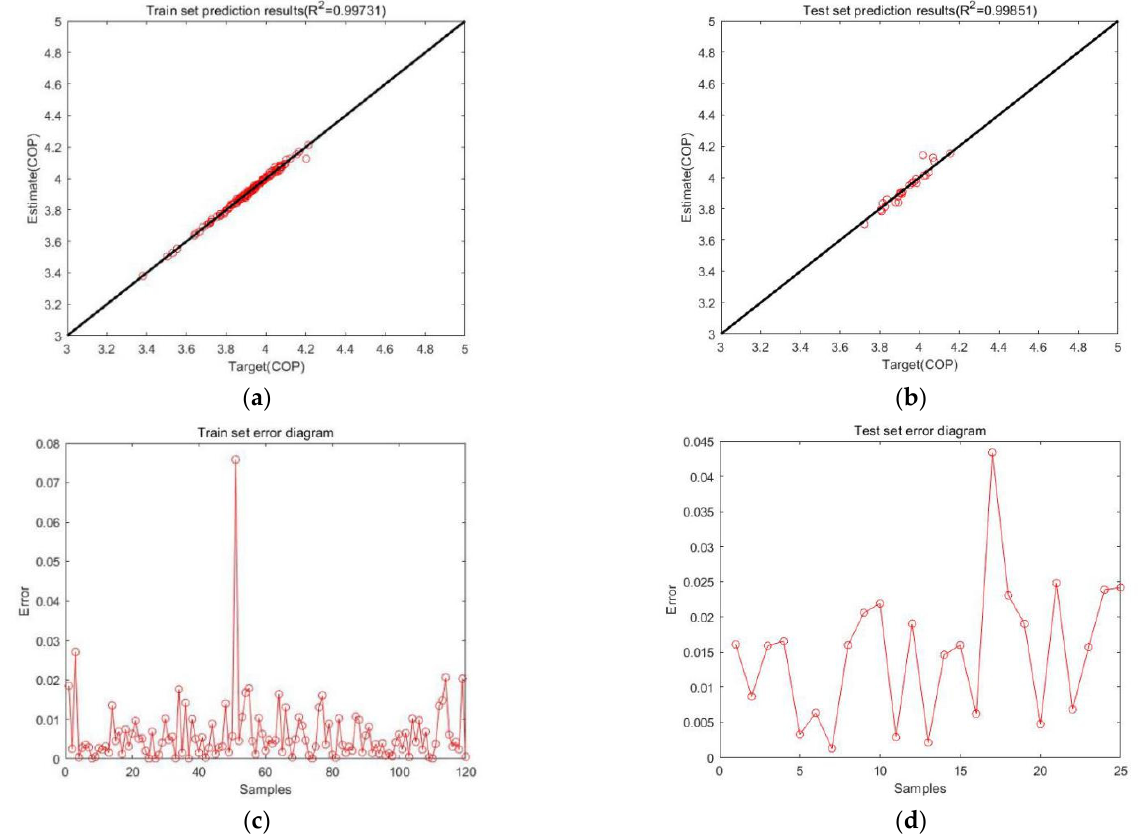
Figure 9. BPNN result diagram. ( a ) Training set fitting effect; ( b ) Test set fitting effect; ( c ) Training set prediction error percentage; ( d ) Test set prediction error percentage.